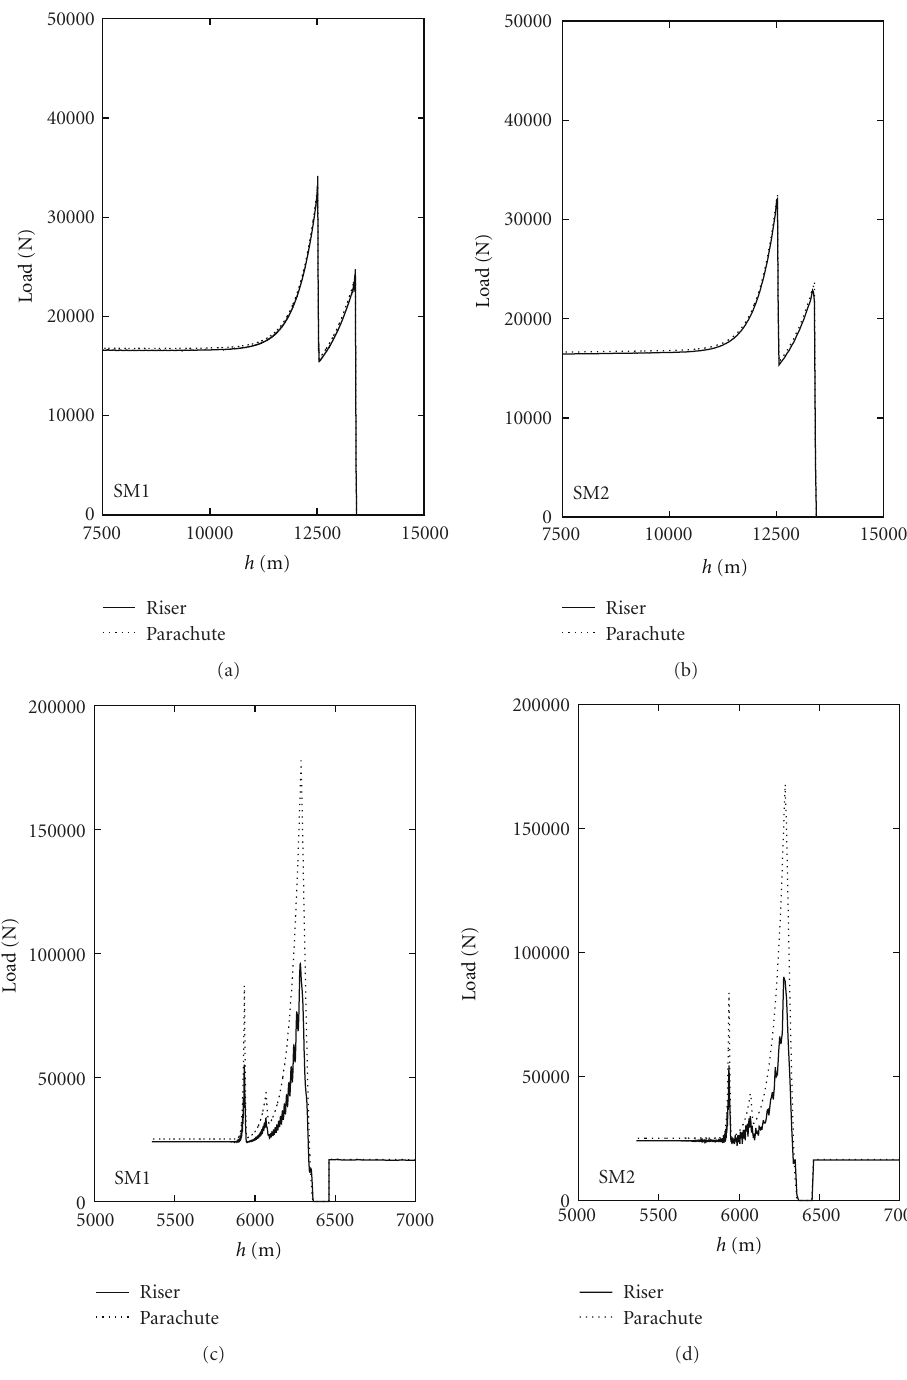
Figure 6: The loads acting on the riser and the decelerator (drogue and main